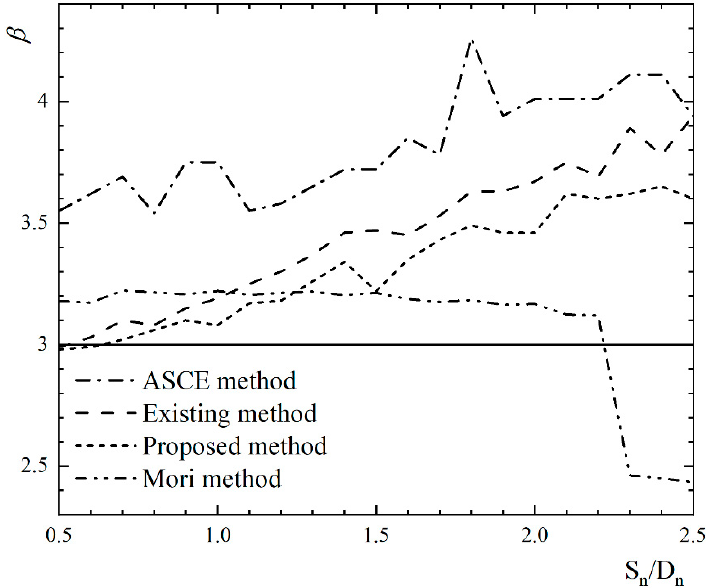
Figure 5. Reliability calculated by different methods for S n / D n = 0.5–2.5 ( β T =3).